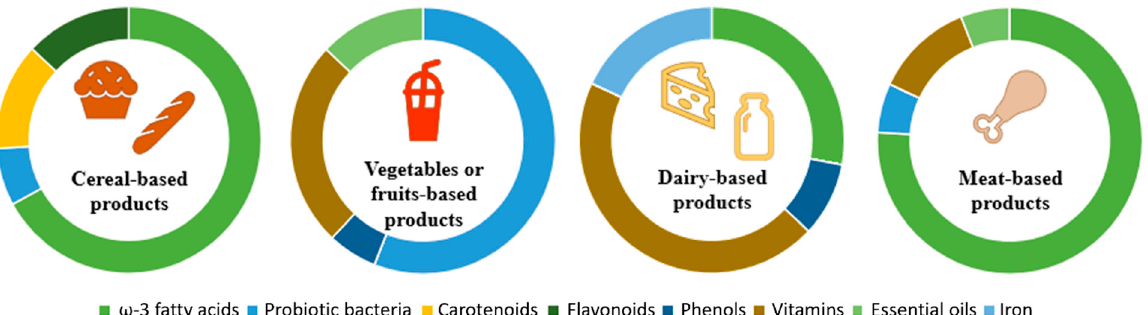
Figure 8. Schematic quantification of the incorporation of selected natural bioactive compounds in real food